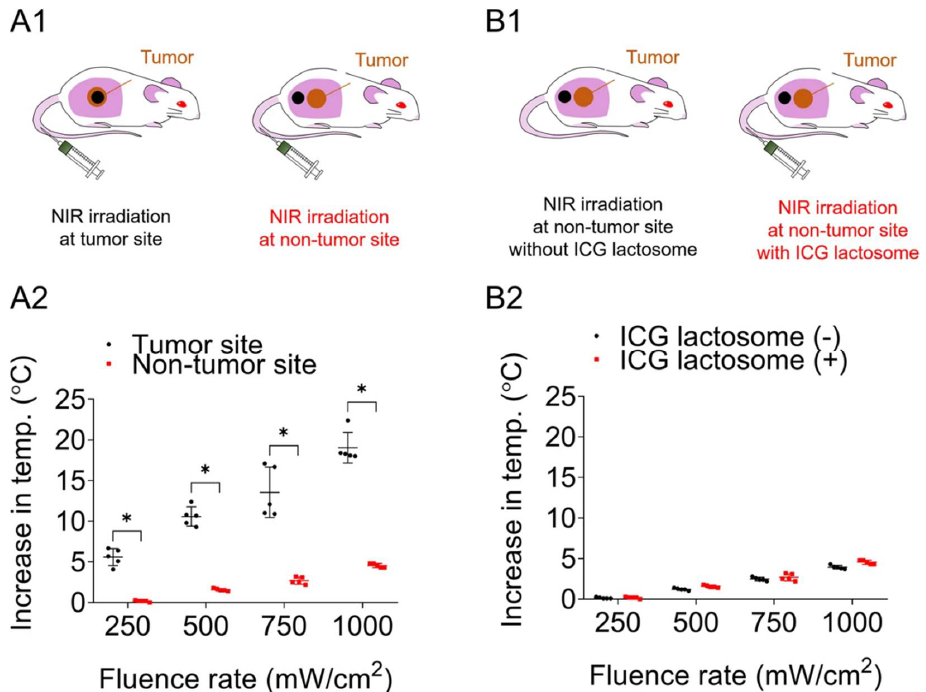
Figure 8. Photodynamic therapy in gallbladder cancer. ( A ) Accumulation of fluorescence imaging in mouse subcutaneous tumors after administration of ICG or ICG-lactosomes was observed daily using in vivo imaging systems. On the second day following administration, PDT was performed in groups with ICG ( n = 5, open circles) and single (ICG-Lact1, n = 5, closed squares) or double PDT with ICG-lactosomes (ICG-Lact2, n = 5, closed triangles). The second irradiation was performed on day 5. ( B ) Effect of PDT on tumor growth in mice with subcutaneous tumors treated with ICG and ICG-lactosomes. On the second day following administration, PDT was performed in the ICG ( n = 8, open circles) and ICG-Lact1 ( n = 8, closed squares) groups. The second PDT was performed 3